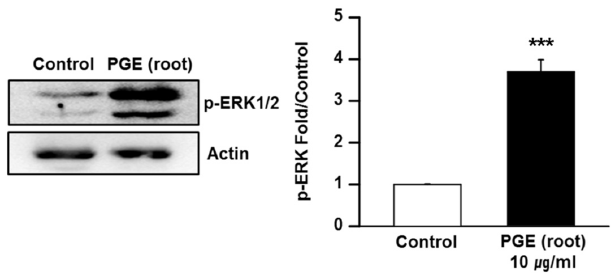
Figure 7. Immunoblotting of PGE (root) treated PC12 cells with ERK1/2. Cells were treated with PGE (root) for 24 h and assayed by western blot using anti-ERK1/2 antibodies and anti-phospho-ERK1/2 antibodies (Thr202/Tyr204). PGE-(root) treated PC12 cells show a significant increase in ERK1/2 phosphorylation. Values are the mean + SEM. *** p < 0.05 compared to the vehicle-treated control group. PGE, Platycodon grandiflorus extract.